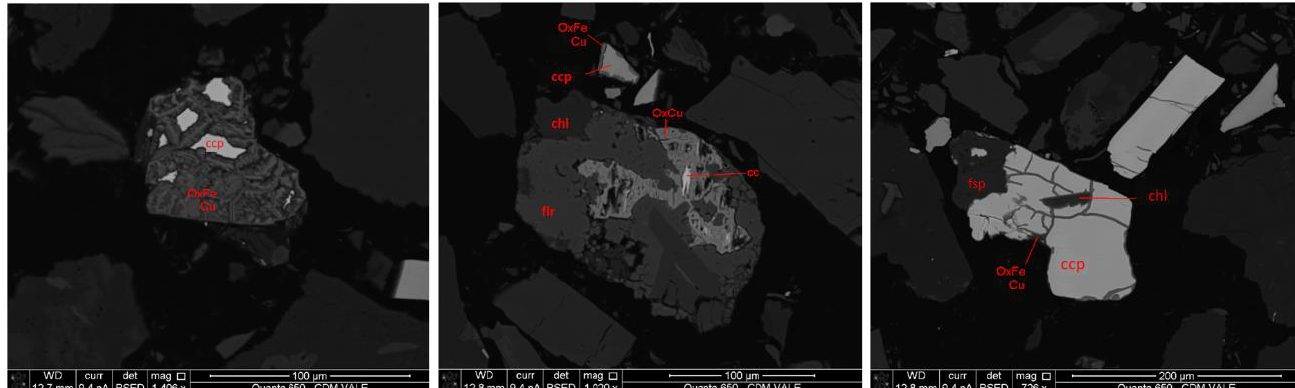
Figure 18. Backscattered electron images of the rougher tailings of sample 6Y-4m-1 × 0 showing several grains of chalcopyrite (ccp) partially altered to Cu-Fe oxides. Complete list of acronyms and chemical formulas in Table S1.